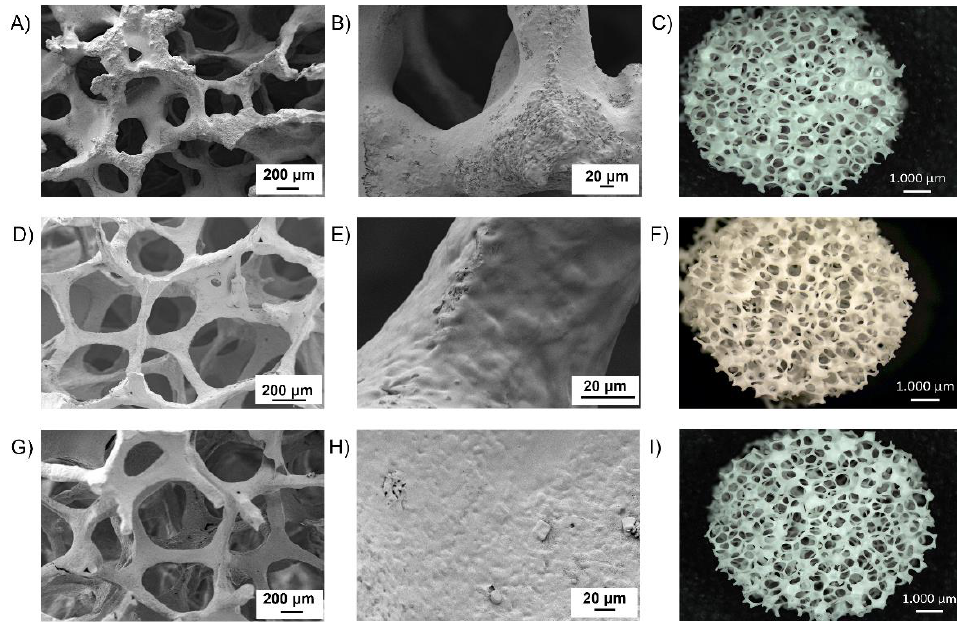
Figure 8. SEM micrographs and light microscope image (top-view) of PCL/BG scaffolds ( A – C ), KHC2000/BG scaffolds ( D – F ), and KHC2000E2000/BG scaffolds ( G – I ).